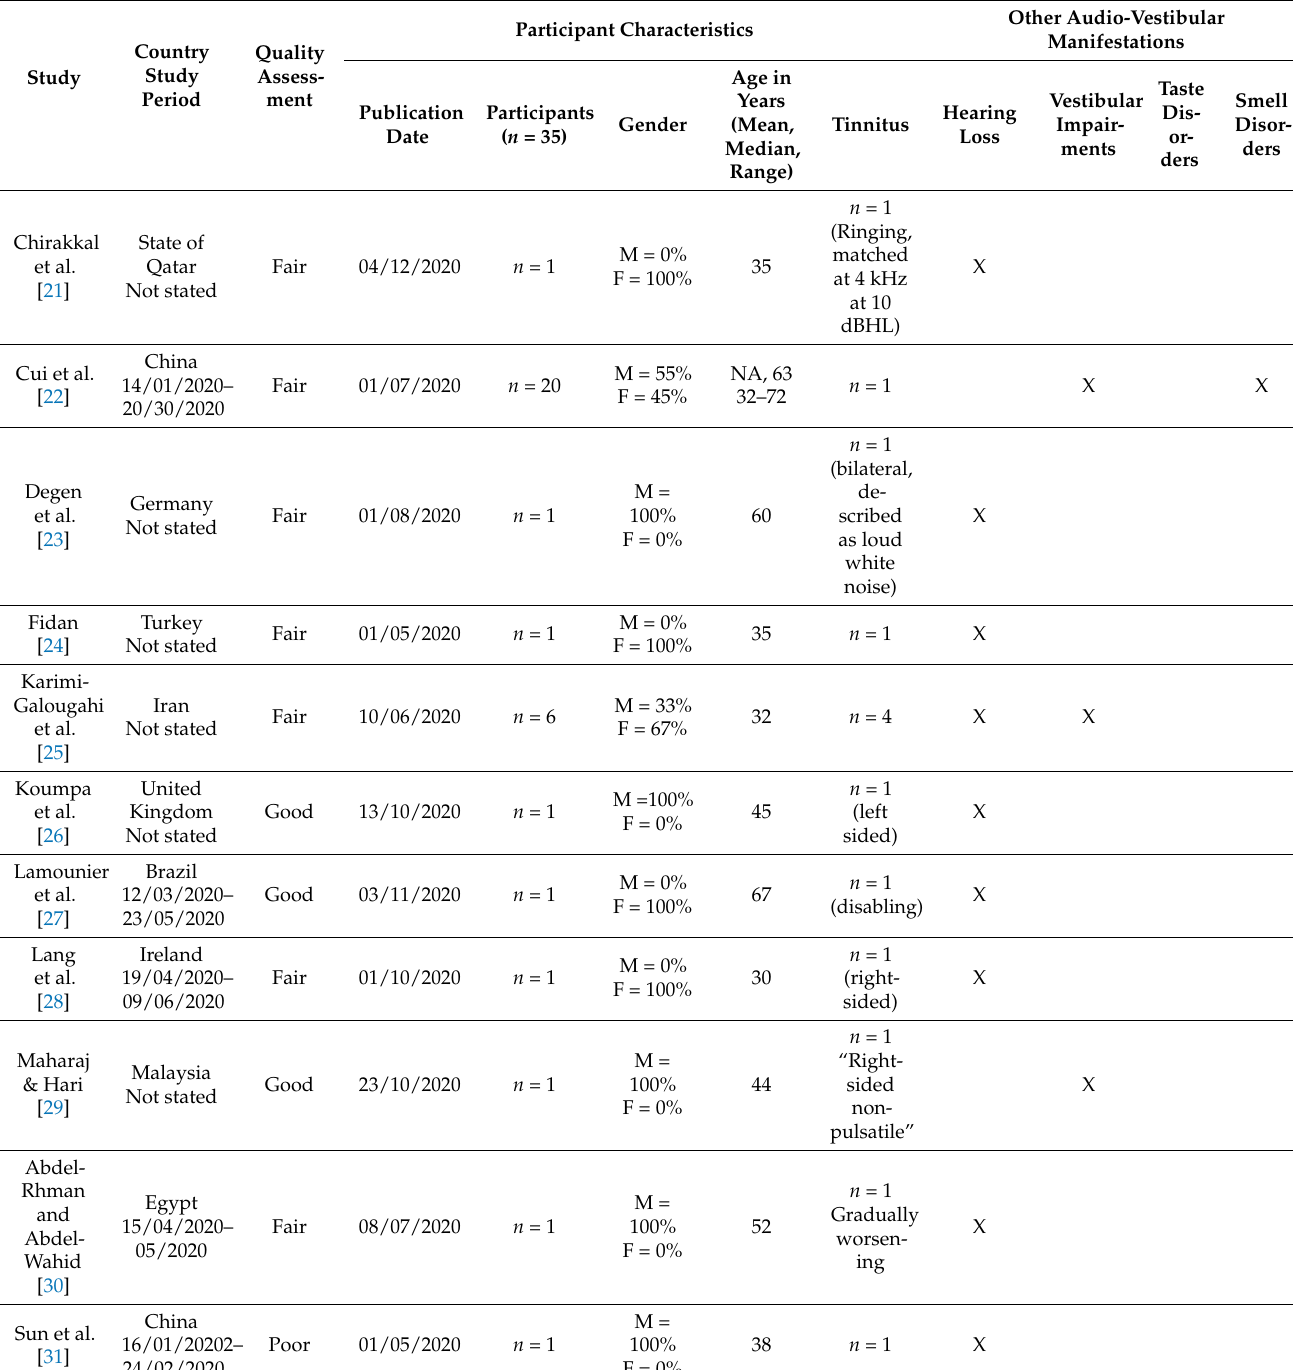
Table 2. Summary of the included COVID-19 disease impact case reports/case series